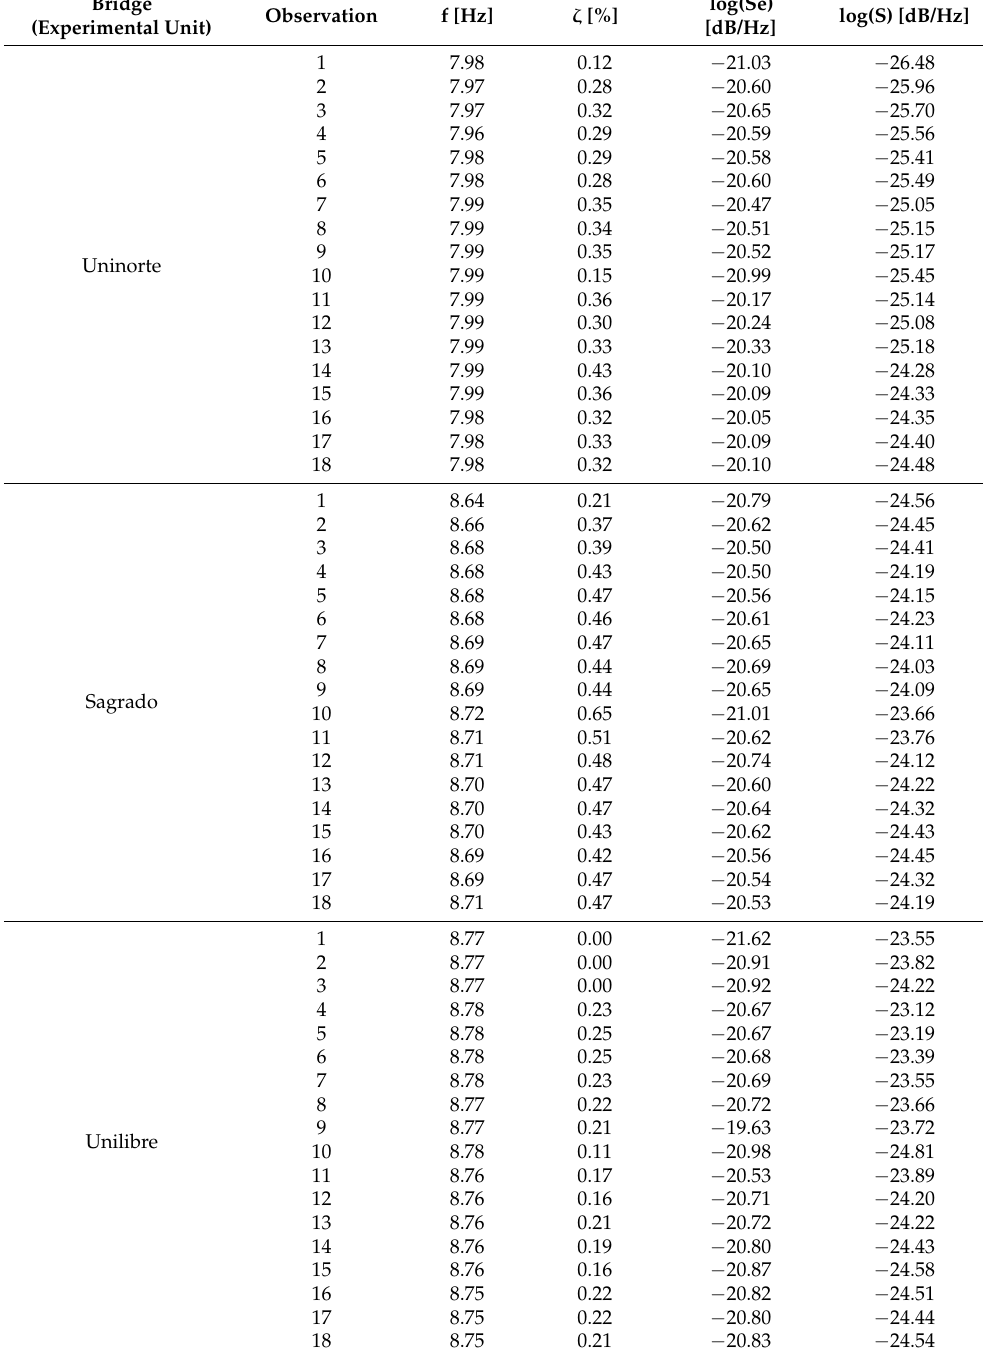
Table 5. Results of the curve fit for each bridge. Bridge (Experimental